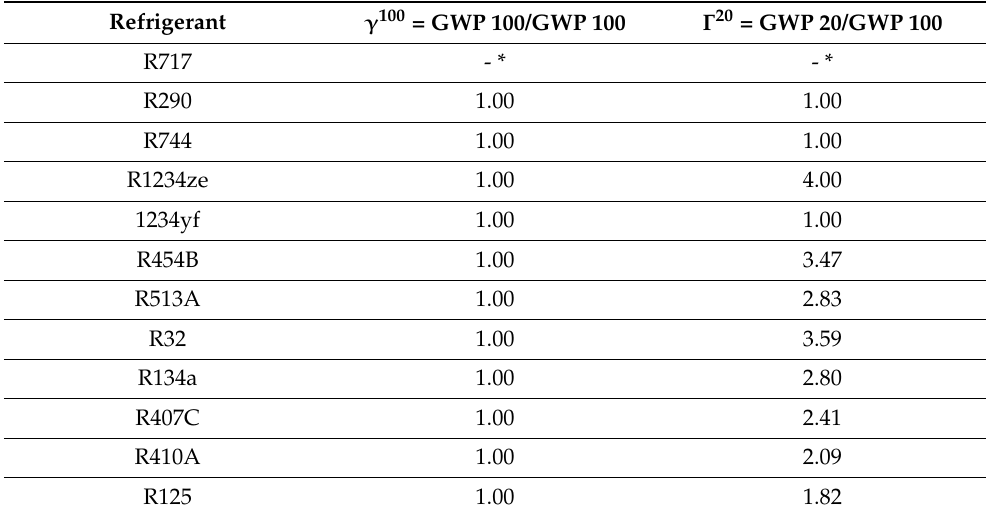
Table 5. Relative values of GWP 100 and GWP 20 with respect to the reference value of GWP 100.